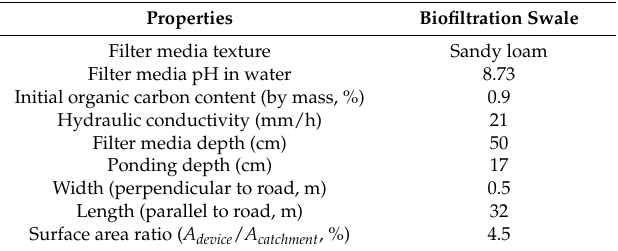
Table 1. Filter media and geometric properties of the biofiltration swale.